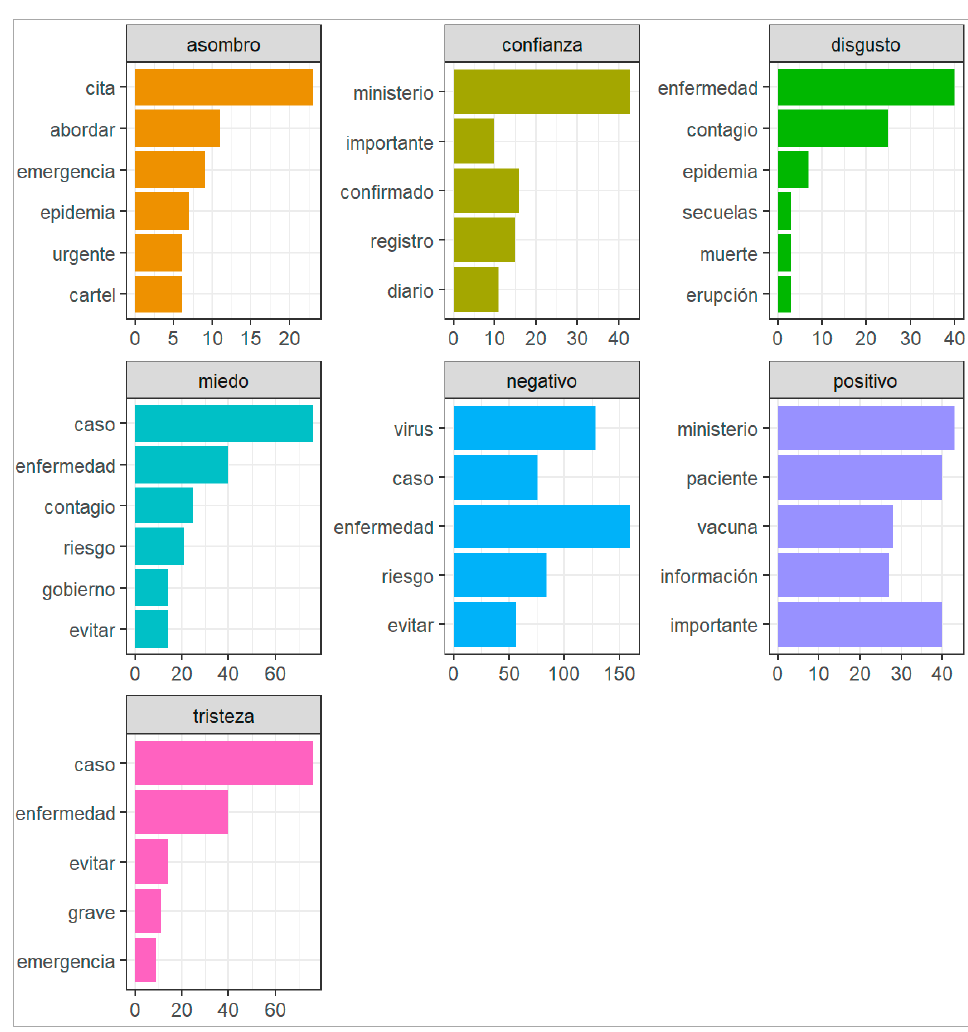
Figure 6. Words grouped by sentiment.